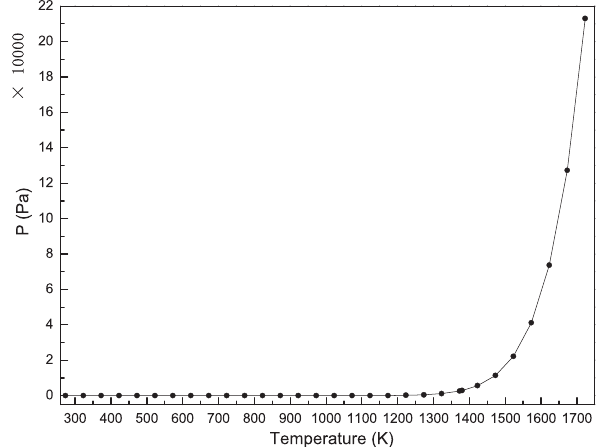
Fig. 3: The curves of lg P − lg 1/ T for Eq.